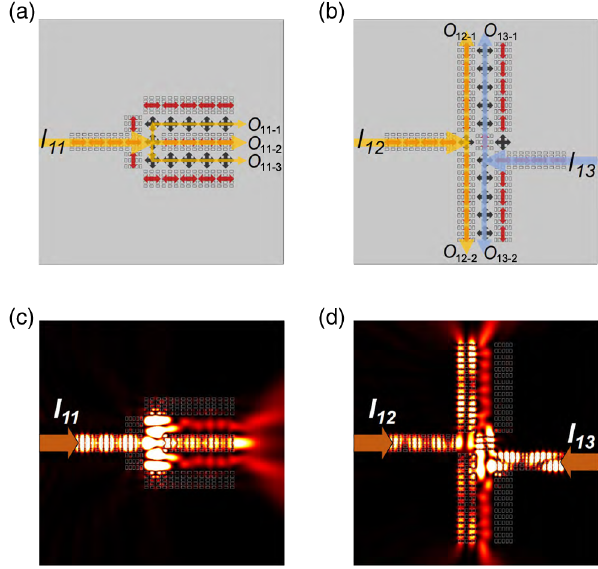
FIG. 11. Splitting photonic circuit designs with zero-spacing distance. (a) A splitting photonic circuit has one input port and three output ports with zero interchannel separation. (b) The splitting photonic circuit has two input ports and four output ports with zero interchannel separation. (c),(d) The simulated intensity distributions under independent excitation from the input ports I i ( i ¼ 11 , 12, 13).